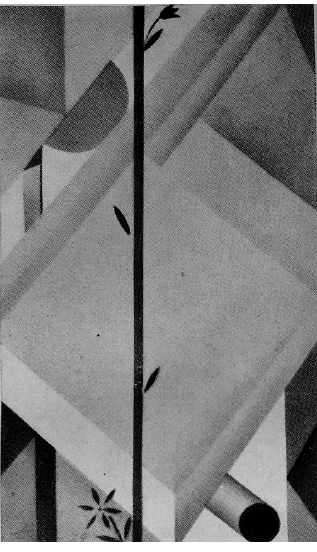
Figure 8. Fides Testi, Fiore di città , panel decorated with airbrush in shades of black, red grey, and blue. About 1930. Photo from (Chiffon 1930). In public domain.